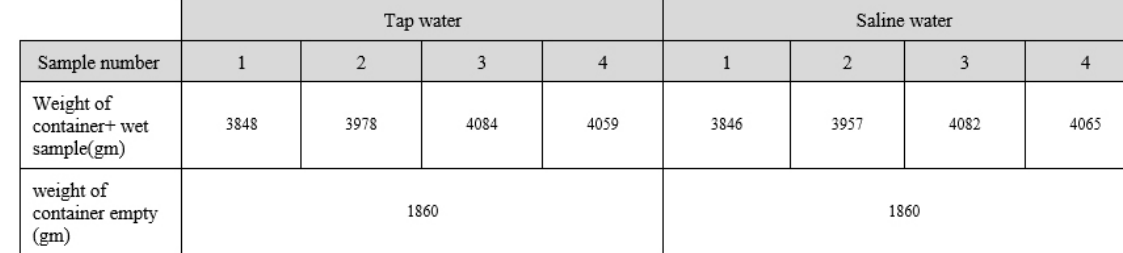
Table 3. Modified pro ctor test results for base mixture using saline water and tap